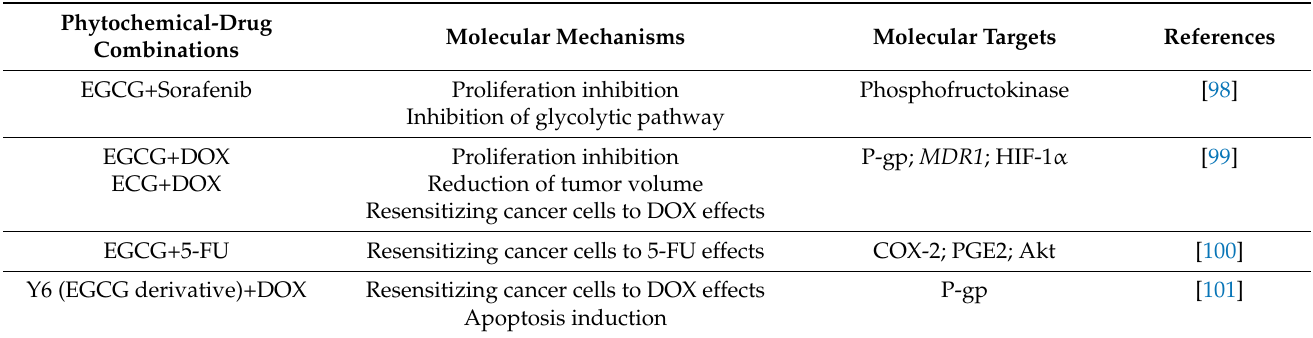
Table 3. Liver cancer